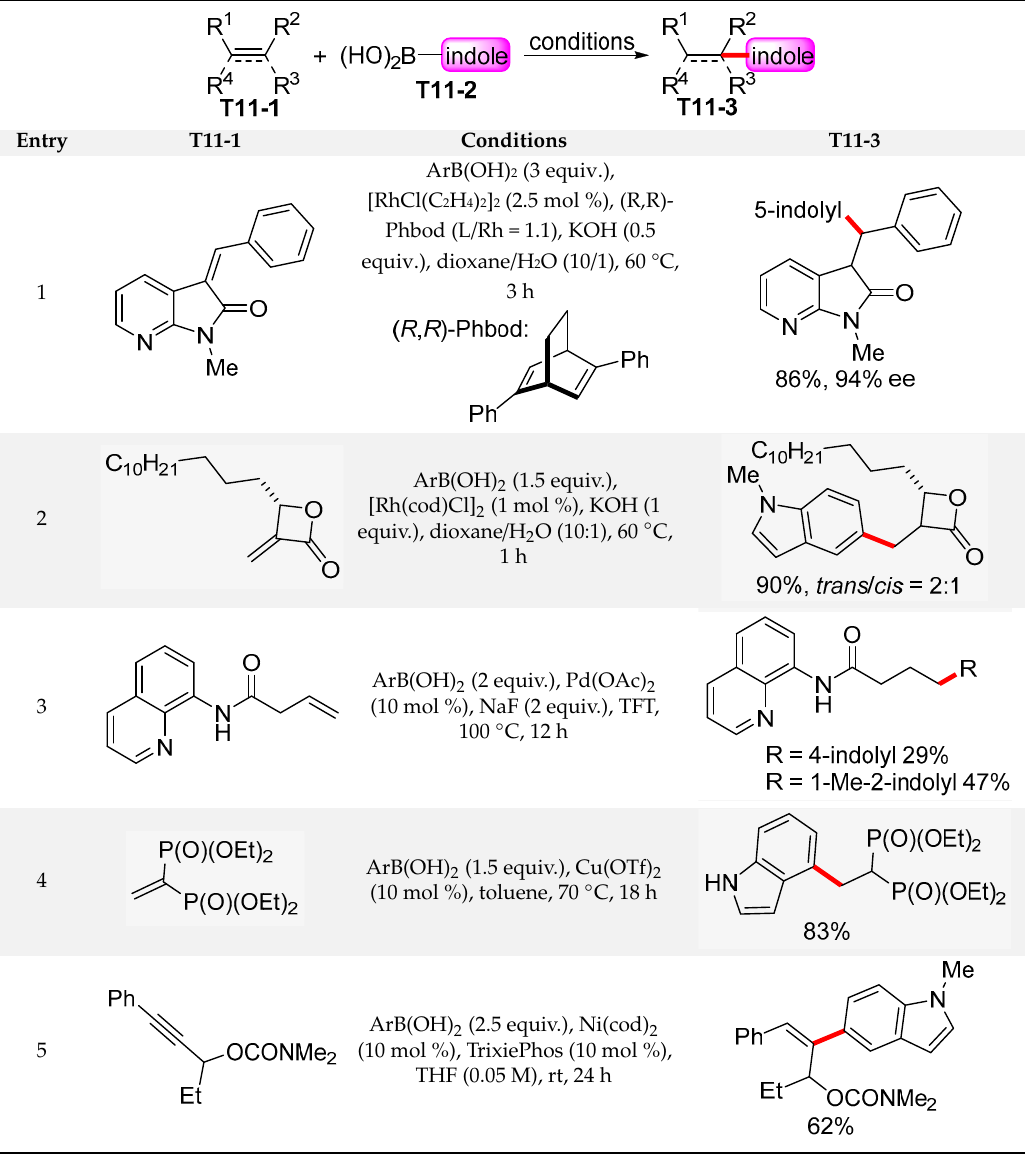
Table 11. Transition-metal-catalyzed reactions of indolylboronic acids with alkenes.